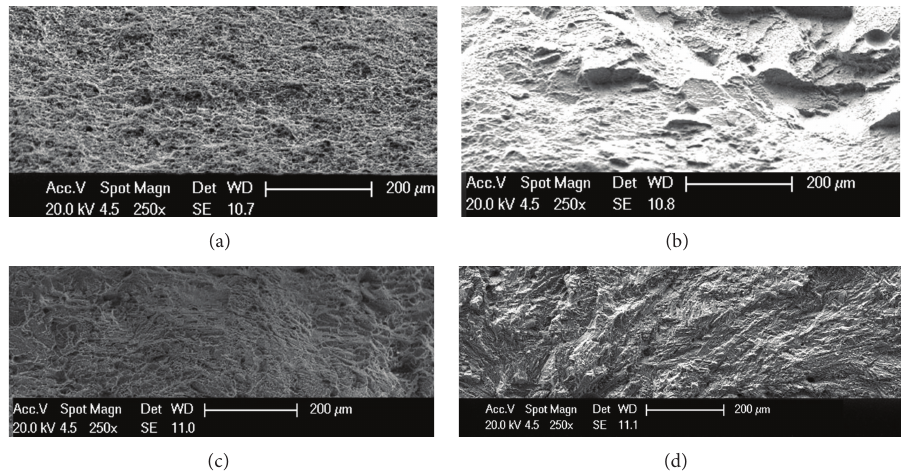
Figure 10: SEM fractographs of the high-cycle fatigue samples of (a) AR material, (b) 1050Q, (c) 950A, and (d)